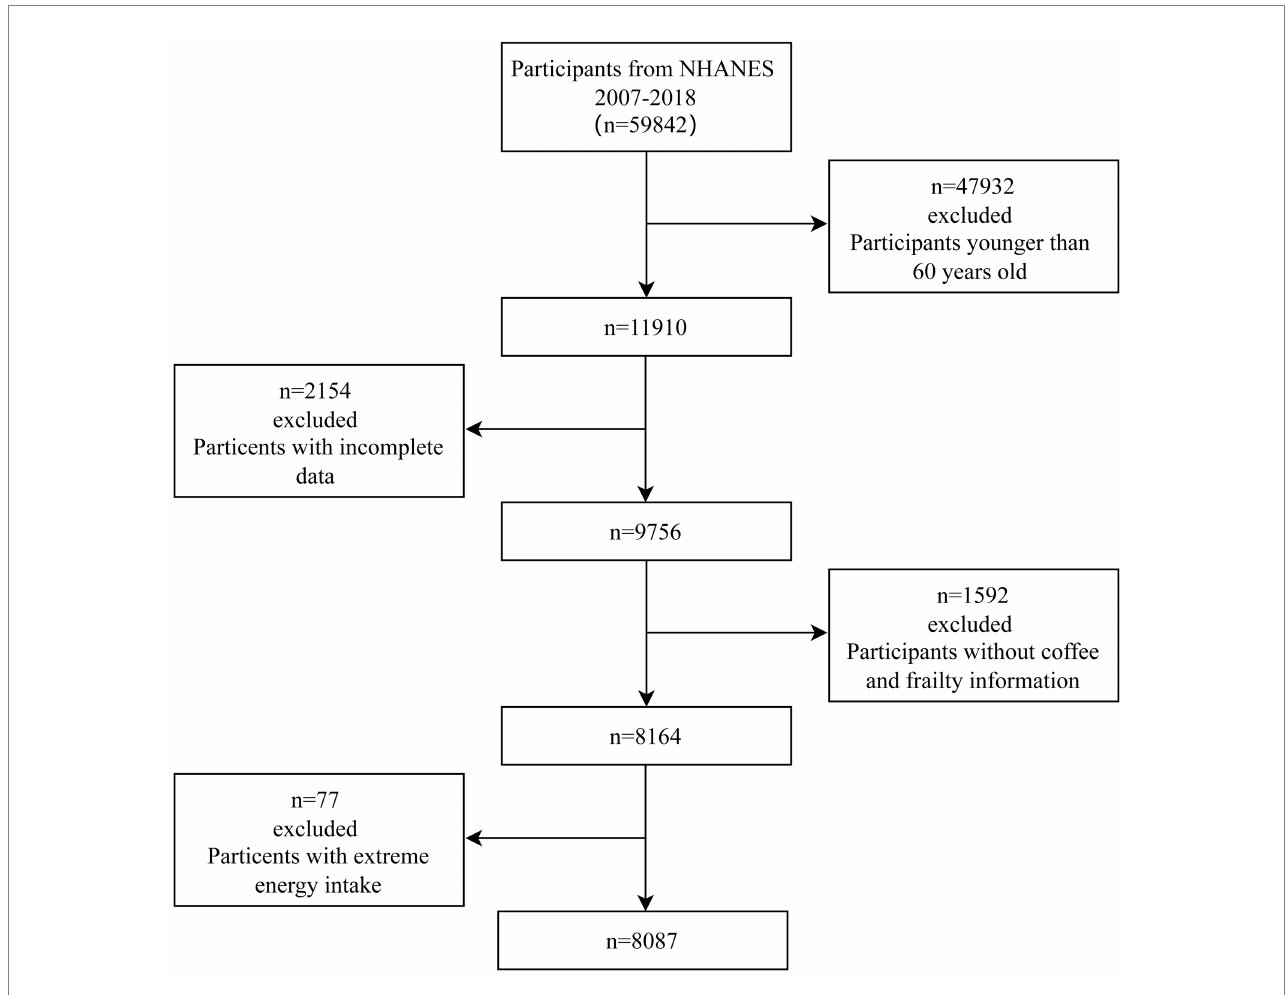
FIGURE 1 Flowchart for the selection of eligible